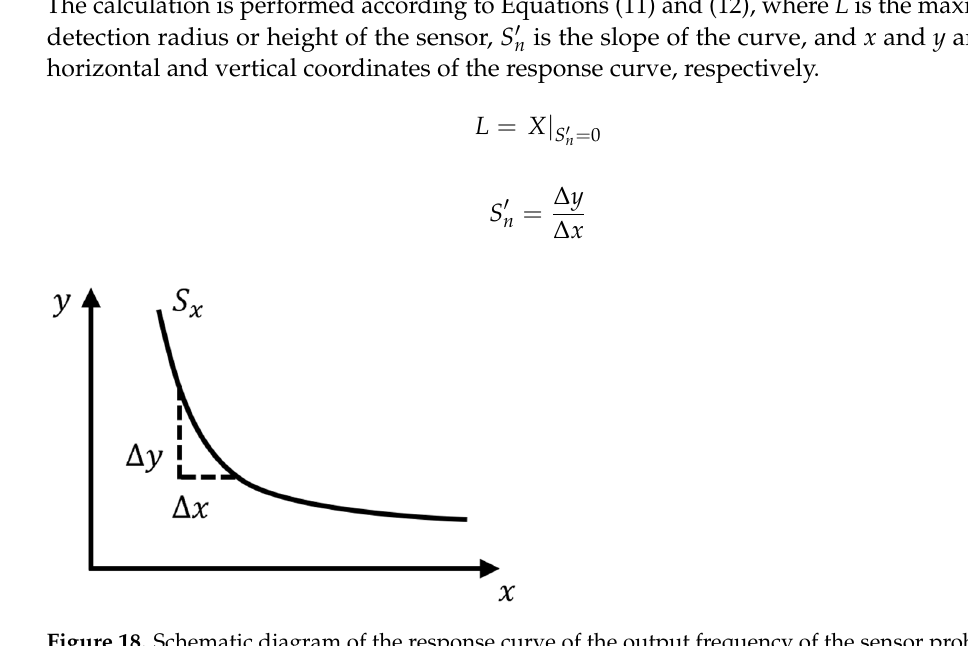
Figure 18. Schematic diagram of the response curve of the output frequency of the sensor probe and the radius or height of the soil sample to be measured.